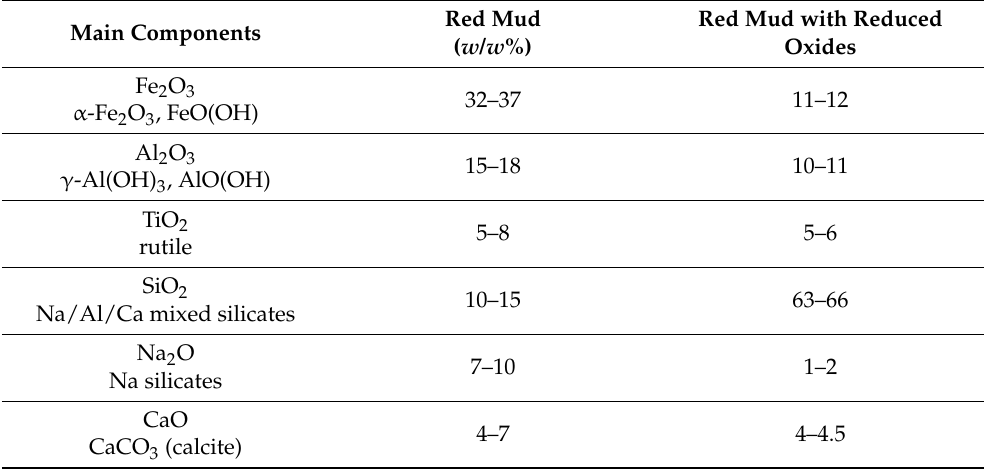
Table 3. The chemical components of red mud-based industrial wastes and their mineral sources. Main